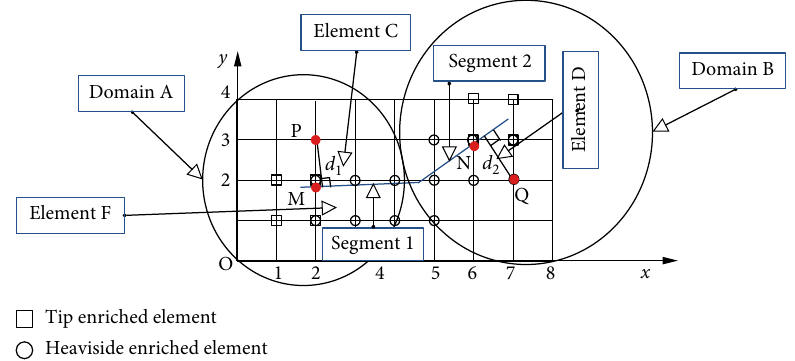
Figure 3: Sketch for the comparison of the proposed tracking technique and the narrow band method.